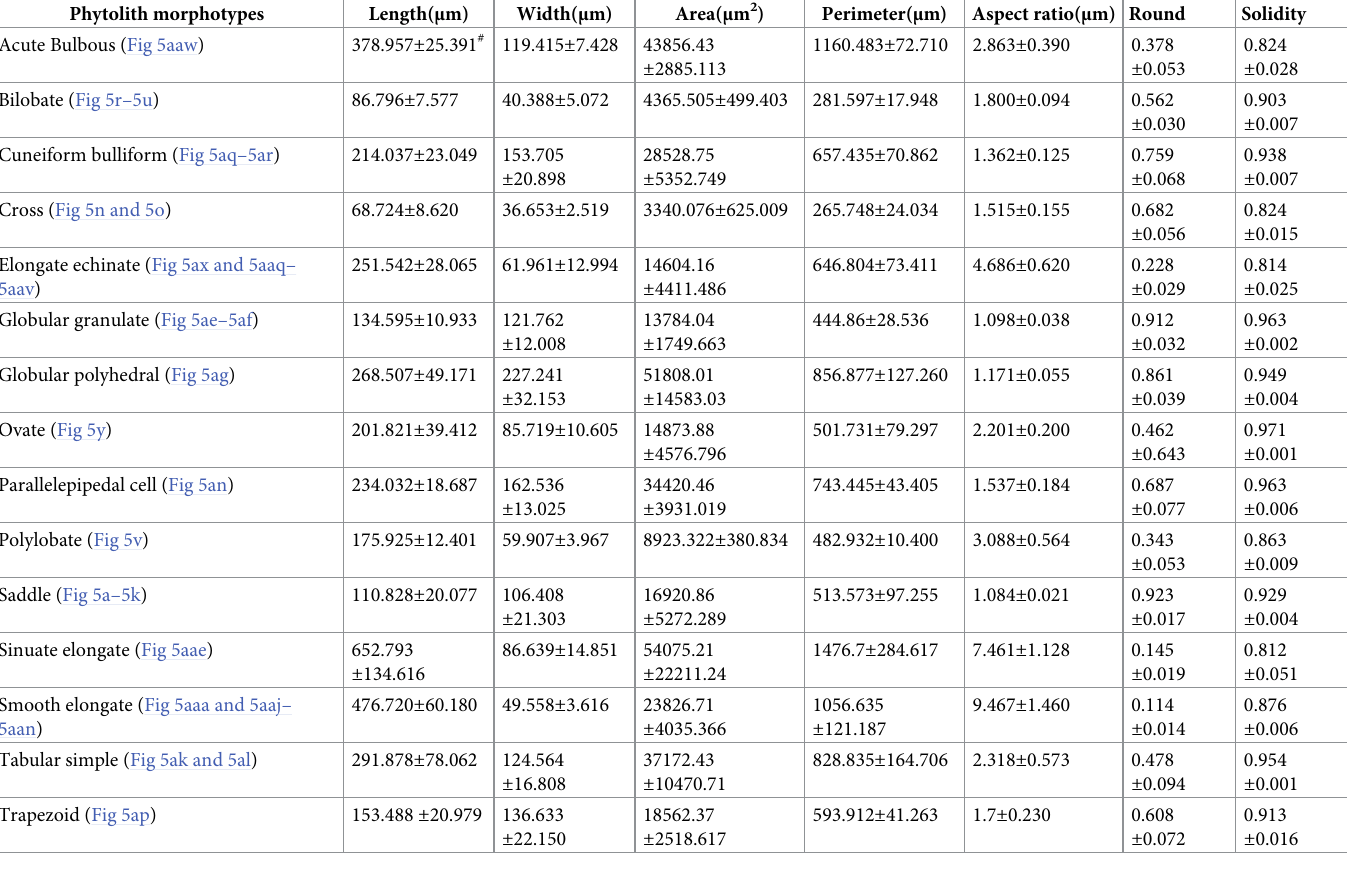
Table 4. Morphometry of phytolith morphotypes of Acrachne racemosa (Heyne ex Roem. & Schult.) Ohwi